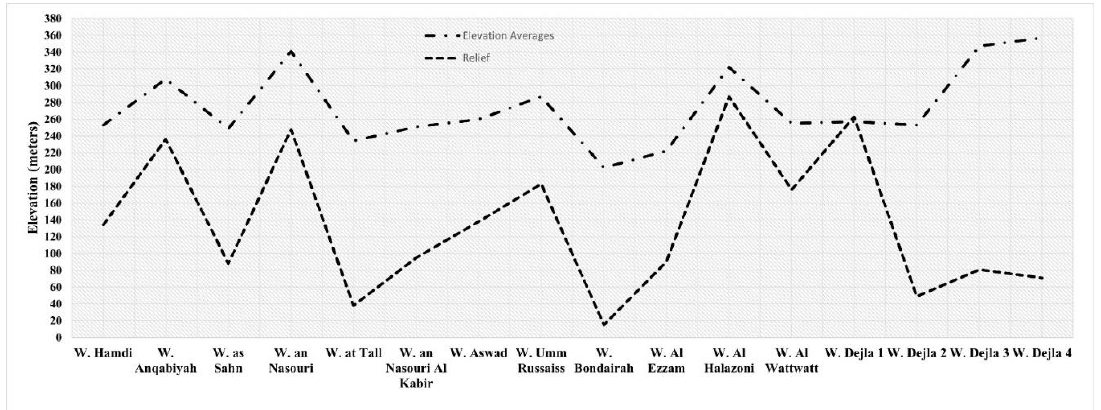
Figure 13. The mean elevations and reliefs of the main valleys of watersheds in the study area.